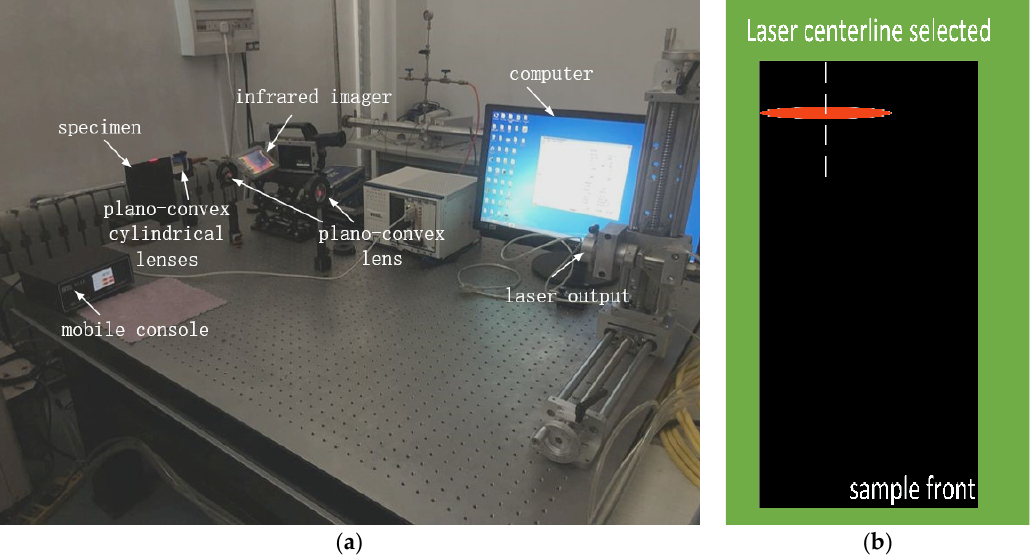
Figure 3. Schematic diagram of the carbon ‐ fiber, pulsed ‐ laser, infrared thermal wave experimental device: ( a ) experimental device diagram; ( b ) the geometry of line ‐ laser.